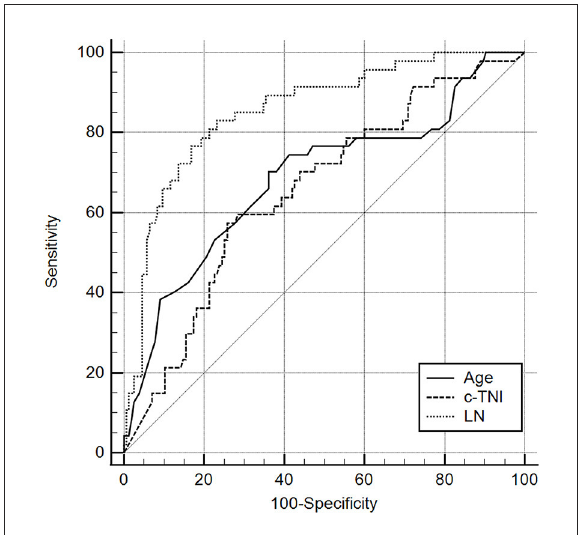
FIGURE1 Receiver operating characteristic curves for laminin, age, and c-TNI in the prediction of MACE in AMI patients. The results showed that the predictive value of LN was significantly higher than that of Age (AUC 0.856 > 0.686, P = 0.0066 < 0.05). It was also significantly higher than that of C-TNI (AUC 0.856 > 0.0655, P = 0.0007 < 0.05).